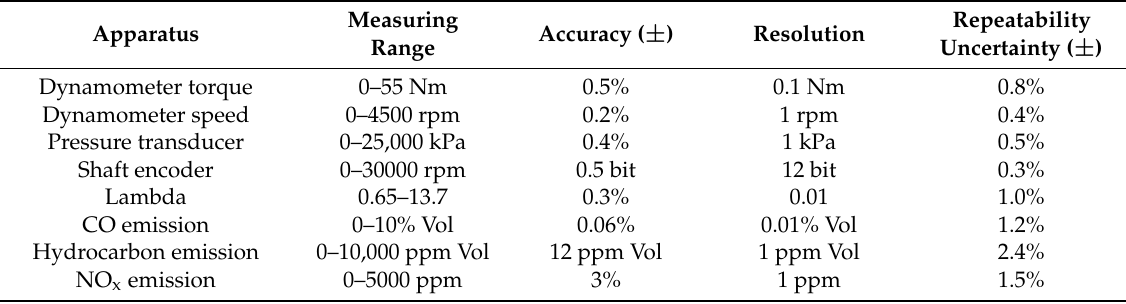
Table 3. Measuring range, accuracy, and resolution of main experimental